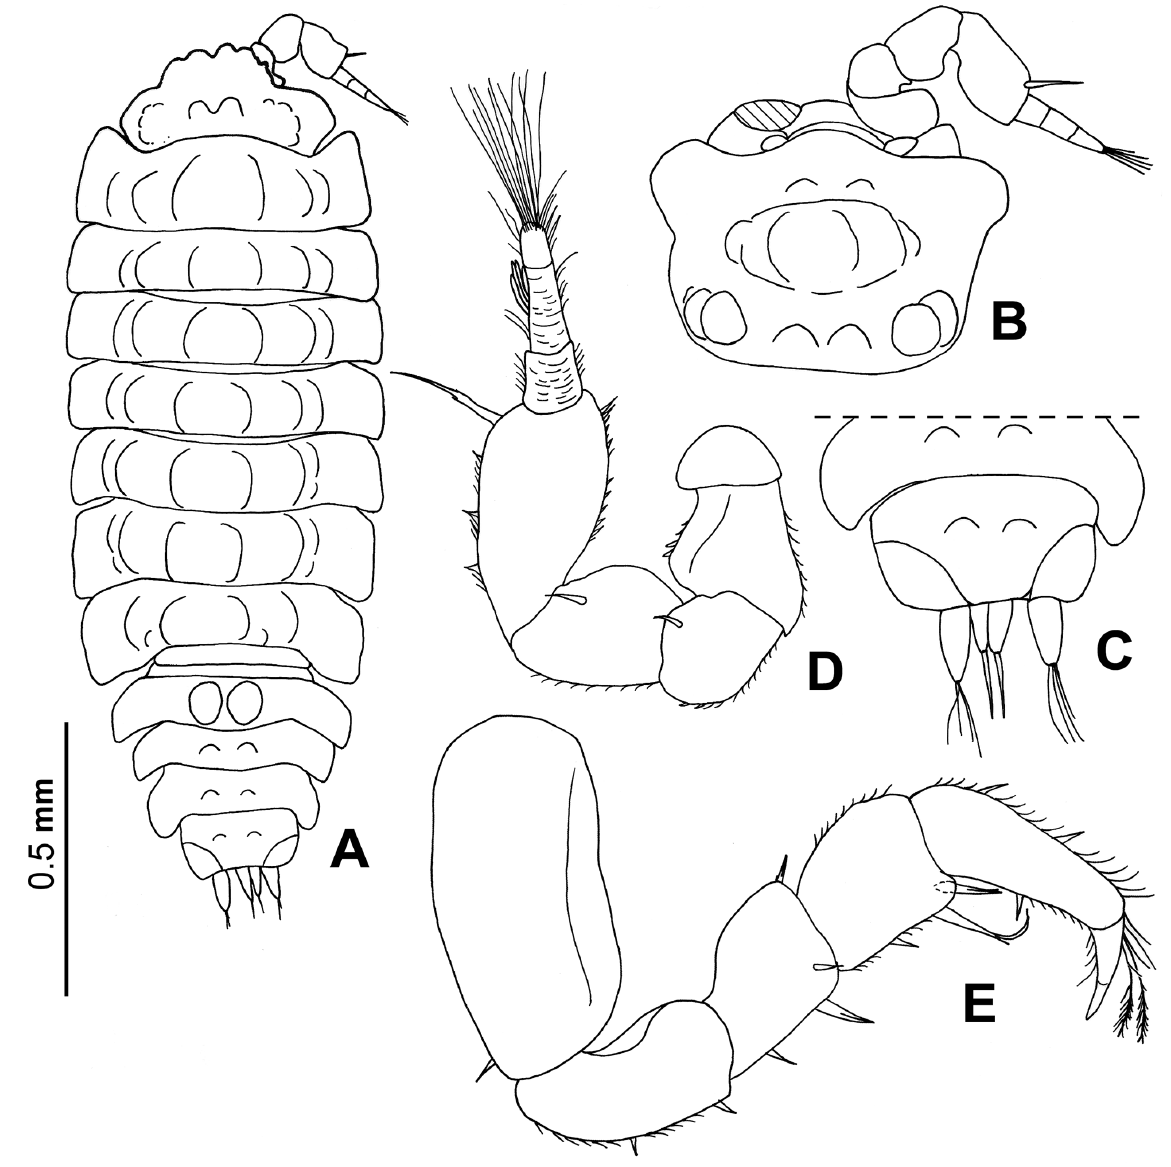
Fig. 21. Moserius inexpectatus Reboleira & Taiti sp. nov. from Gruta do Almonda, Estremenho, paratype, ♂. A . Specimen in dorsal view. B . Cephalon in dorsal view. C . Pleonite 5, telson and uropod. D . Antenna. E . Pereopod